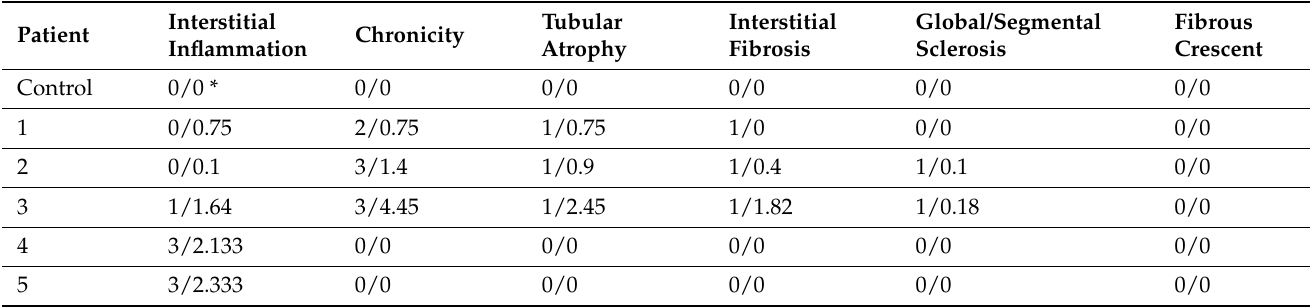
Table 2. Comparison of 2D and 3D average scores of interstitial inflammation, chronicity, and items in chronicity in control and pSLE patients with lupus nephritis class